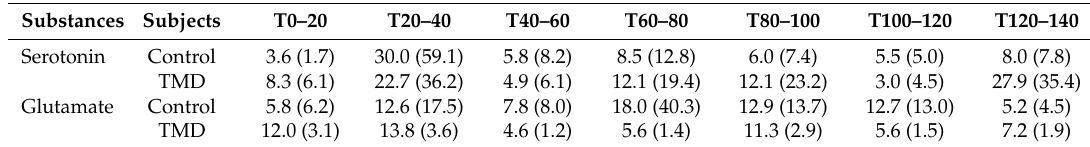
Table 1. Mean (SD) interstitial serotonin and glutamate at different time points for the healthy control group ( n = 15) and the myofascial temporomandibular disorders (TMD) group ( n = 15).